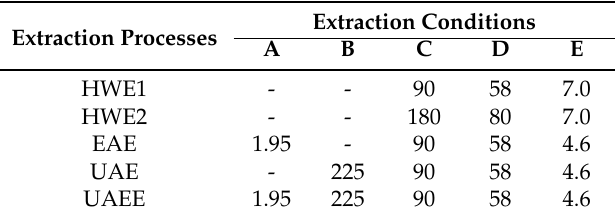
Table 4. The differrent extraction process of